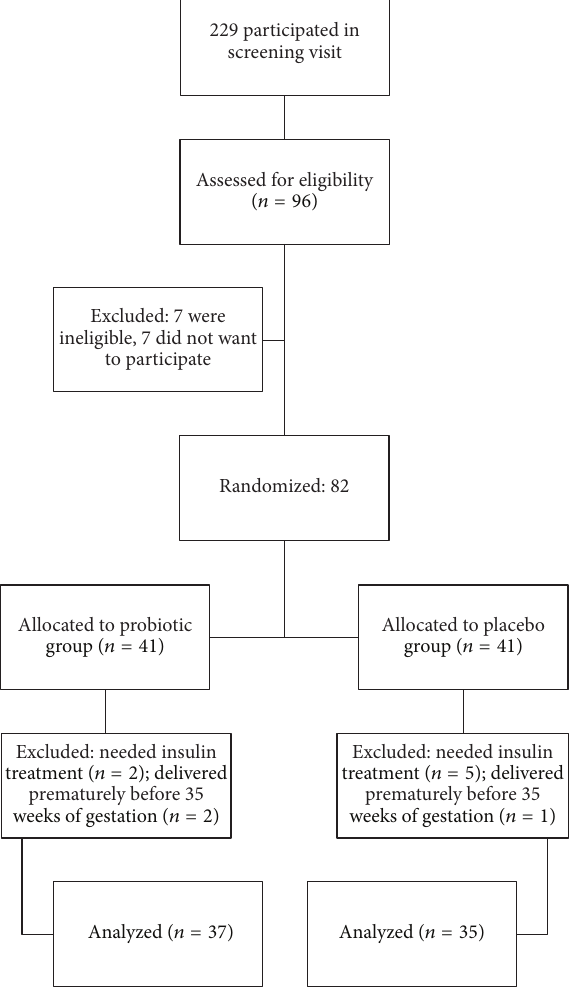
Figure 1: Flow diagram of the study.